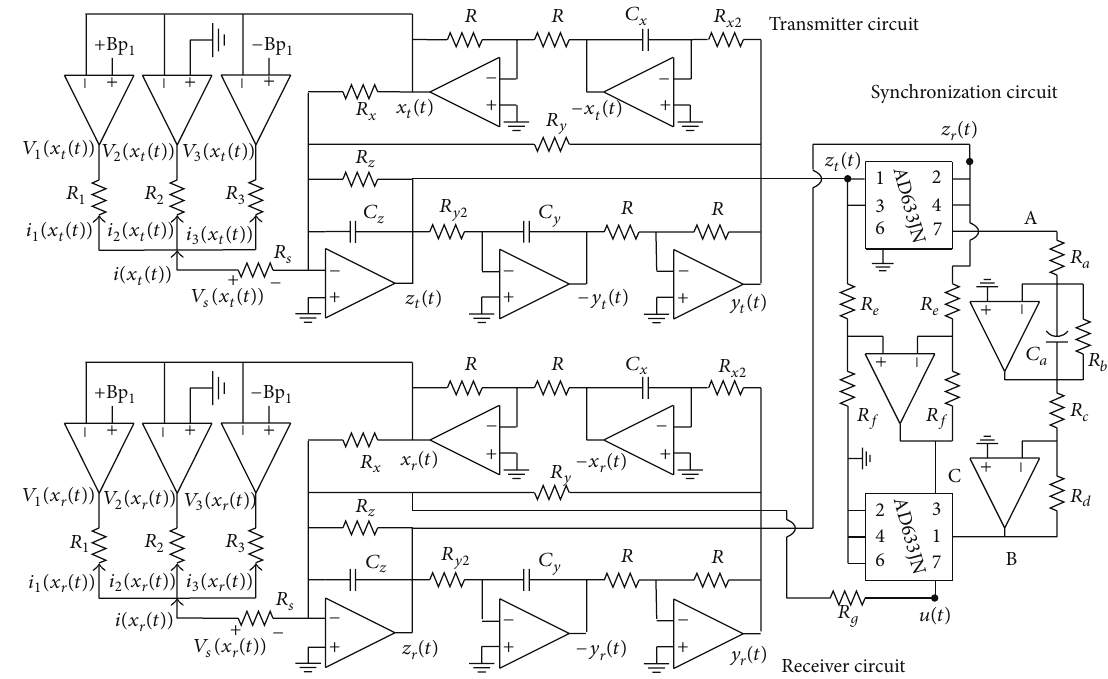
Figure 3: Full synchronization